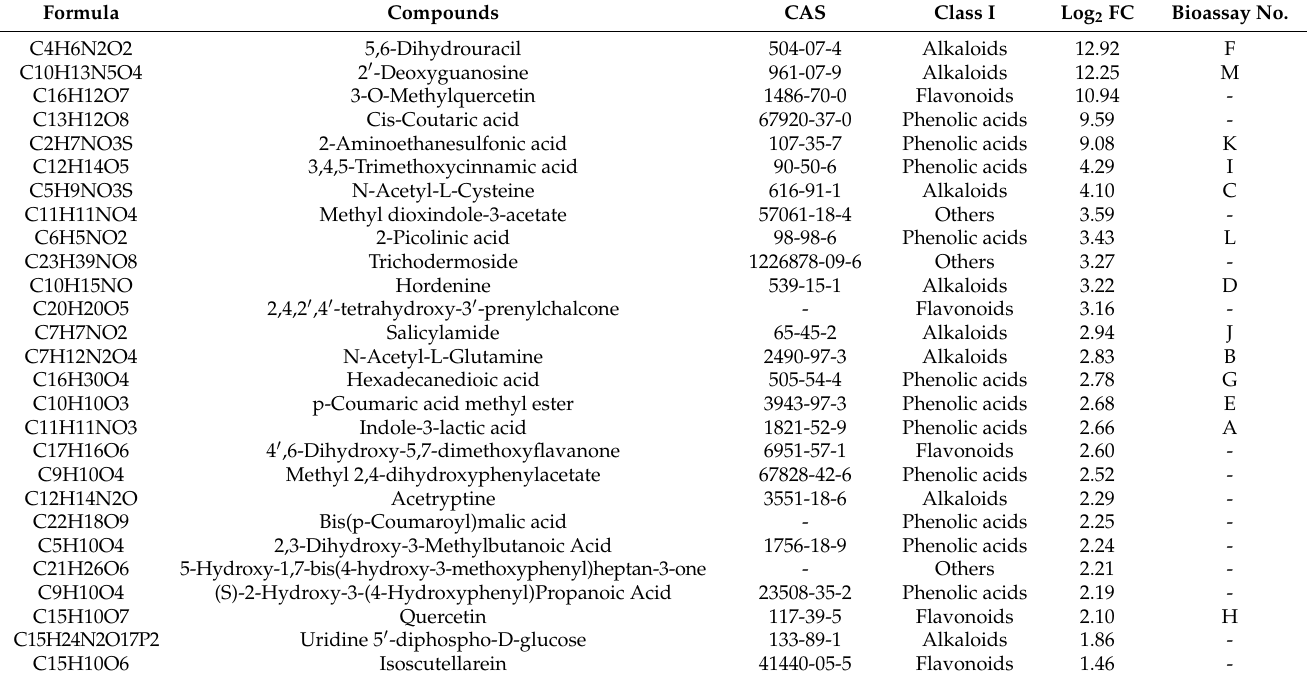
Table 1. The compounds upregulated in the CF of 51-13 compared with that of T-51.